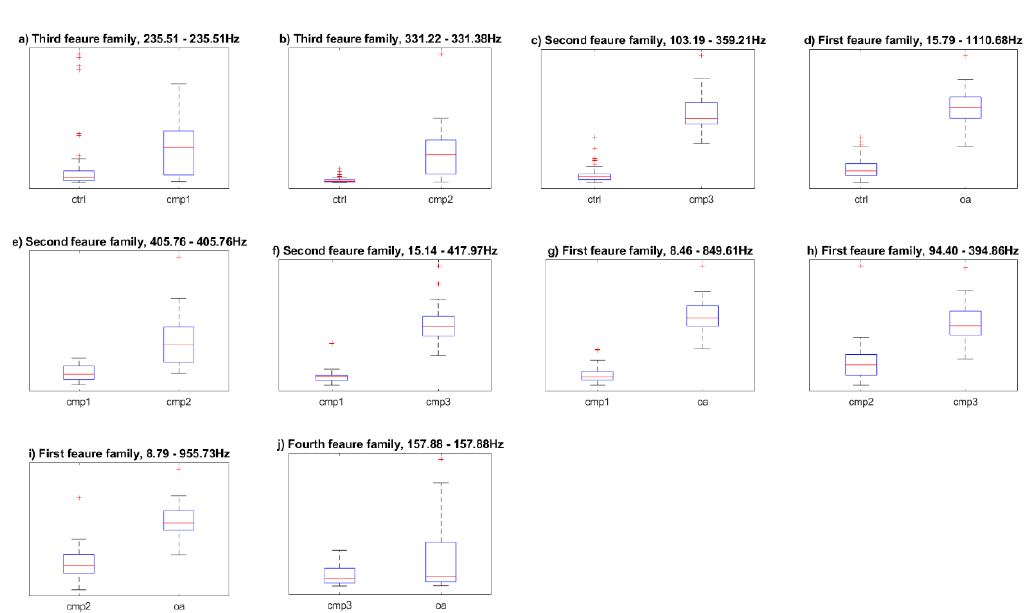
Figure 7. Boxplots of the best results for each class combination. The class distinctions are following: ( a ) ctrl-cmp1, ( b ) ctrl-cmp2, ( c ) ctrl-cmp3, ( d ) ctrl-oa, ( e ) cmp1-cmp2, ( f ) cmp1-cmp3, ( g ) cmp1-oa, ( h ) cmp2-cmp3, ( i ) cmp2-oa, ( j ) cmp3-oa. All of the letters correspond with Tables 1 and 2.